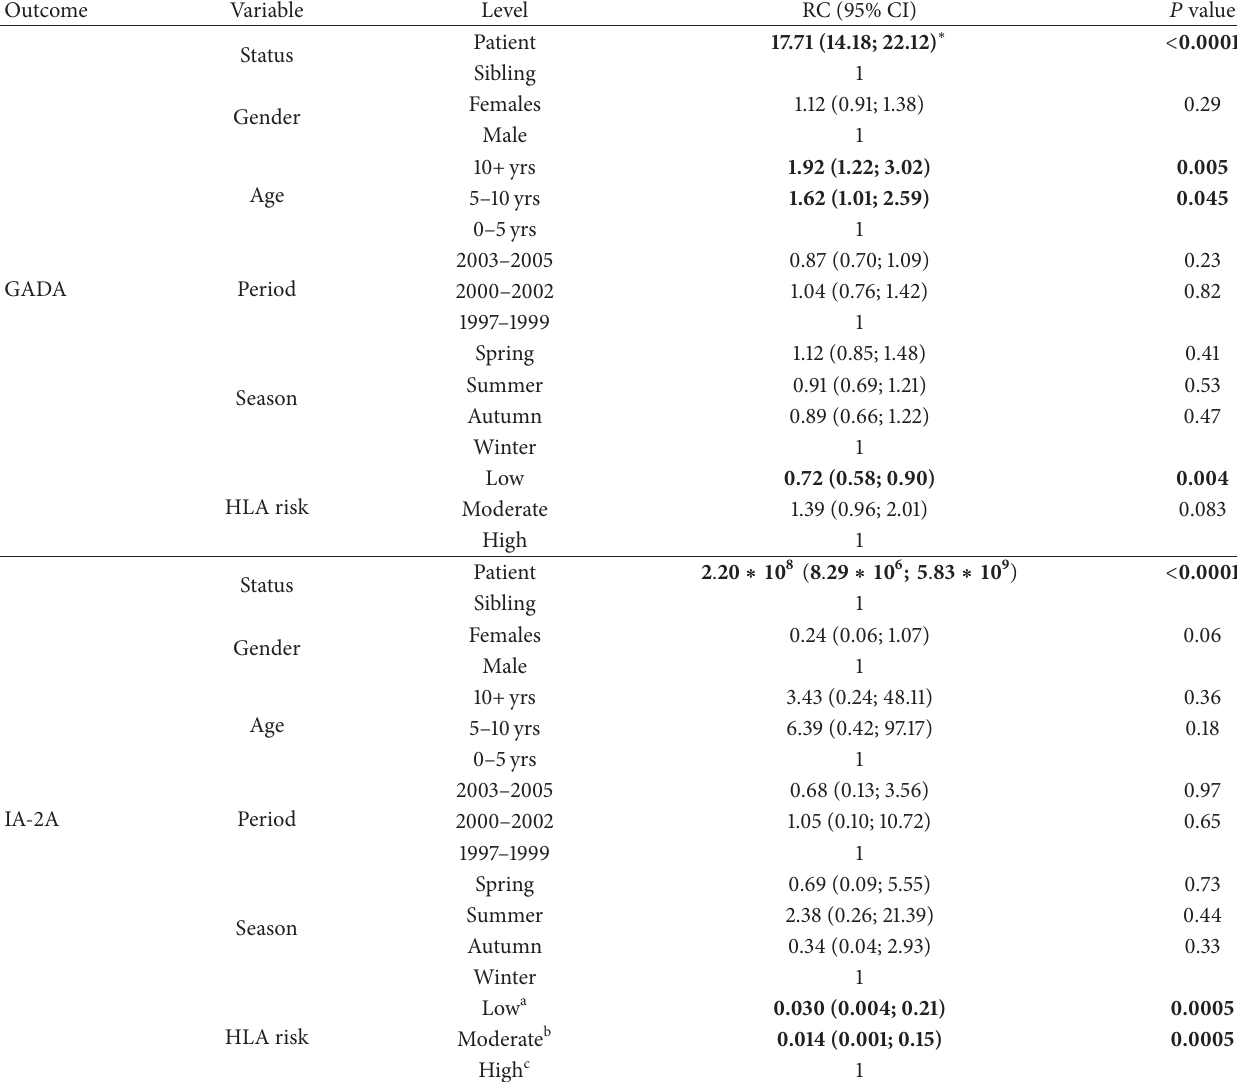
∗ Bold letters indicate significance at a 5 % level. HLA-DQB1 genotypes are collapsed into risk categories, which are seen below. a HLA-DQB1 ∗ allele 1/ ∗ allele 2: 06:02/03:02, 06:02/02, 06:03/99:99, 03:01/99:99, 06:02/03:01, 06:03/03:01, 06:04/03:01, 06:03/02,